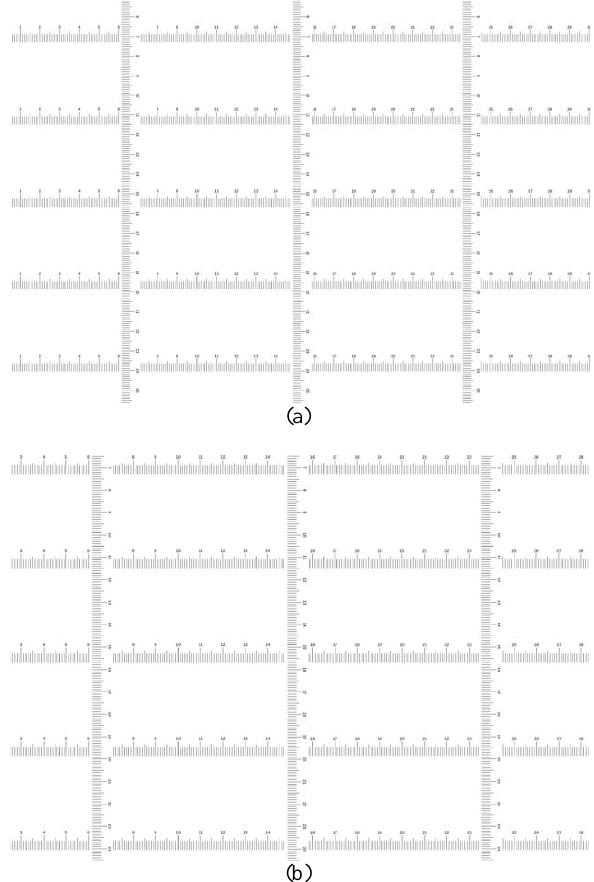
Figure 7. The graduated stable planar test field on 0% water